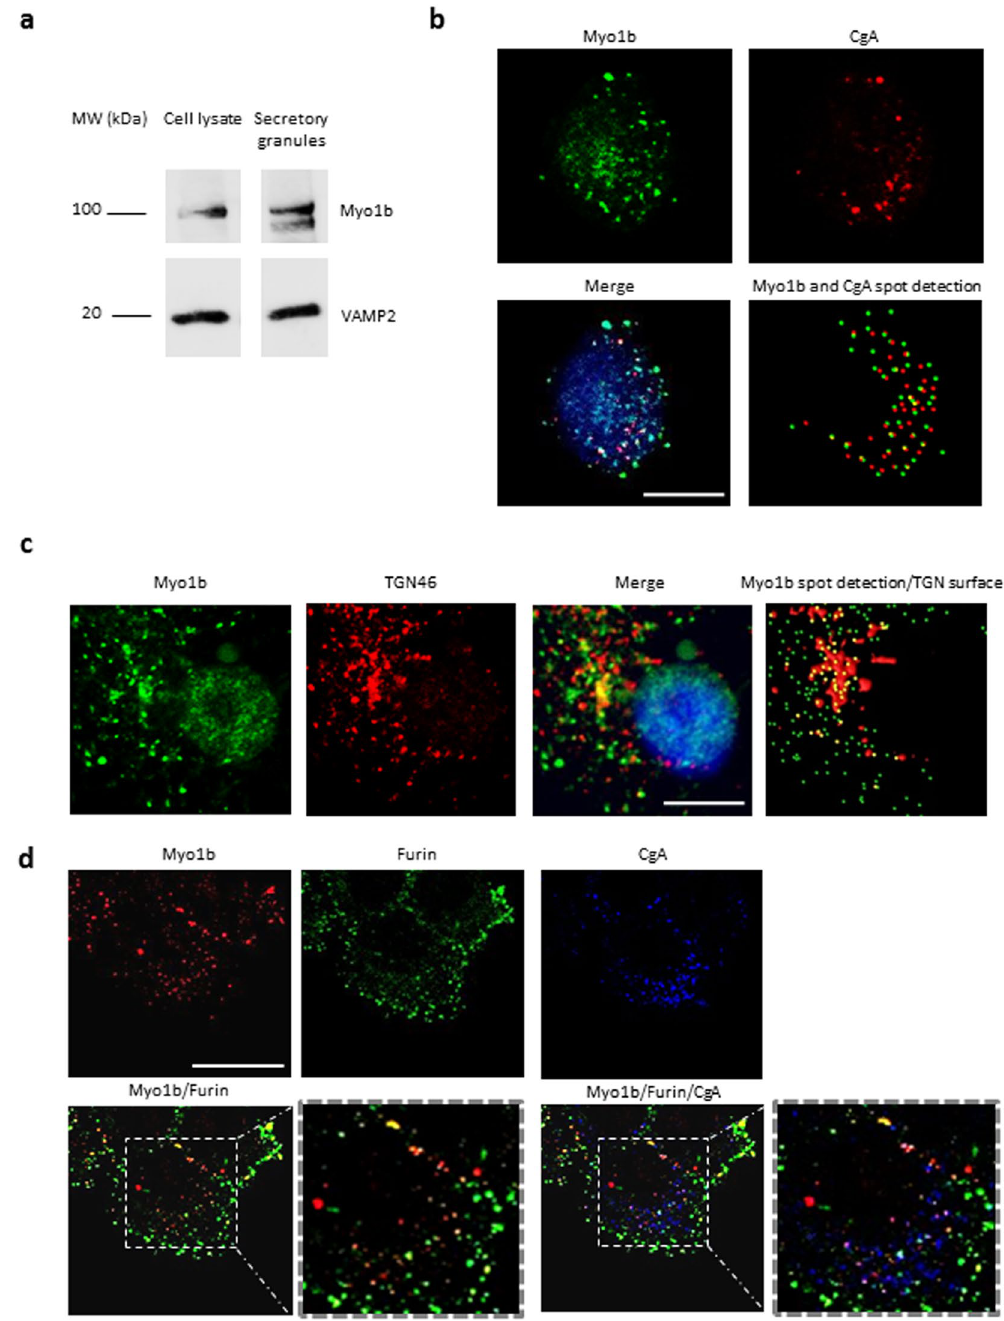
Figure 1. Myosin 1b is associated with the trans-Golgi network and secretory granules in PC12 cells. ( a ) Cropped and color inverted blots showing protein expression levels of myosin 1b (Myo1b) and VAMP2 in a PC12 cell lysate and secretory granule-containing fraction. (Full image of each tested protein are reported in Supplementary Figure S1). ( b – d ) PC12 cells were immunolabeled with anti-TGN46, Myo1b, CgA and furin antibodies. ( b ) Representative confocal microscopy sections throughout the cell show a partial overlap of Myo1b and CgA-containing secretory granules (47 ± 18%, with a 0.409 Pearson correlation coefficient, from three independent experiments, n = 39 cells). ( c ) Representative confocal microscopy sections throughout the cell show an overlap of Myo1b labeling and a TGN marker. ( d ) Representative confocal microscopy sections throughout the cell show an overlap of Myo1b and CgA-containing immature secretory granules labeled by furin (89 ± 8%, from three independent experiments, n = 66 cells). Scale bar represents 10 µ